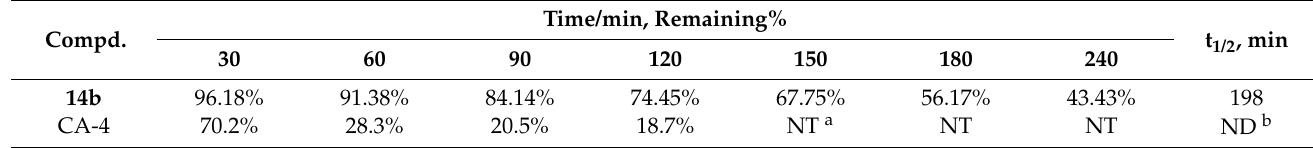
Table 4. The metabolic stability of 14b and